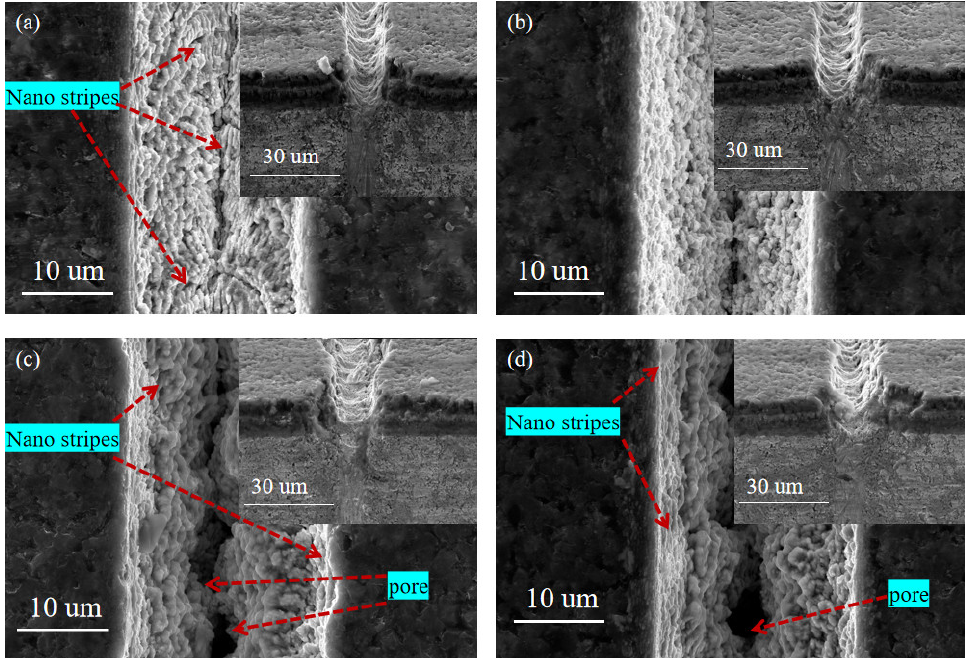
Figure 7. SEM images of micro-texture surface morphology and corresponding section morphology under different laser energy. ( a ) = 5 μJ, ( b ) = 10 μJ, ( c ) = 15 μJ, ( d ) = 20 μJ).